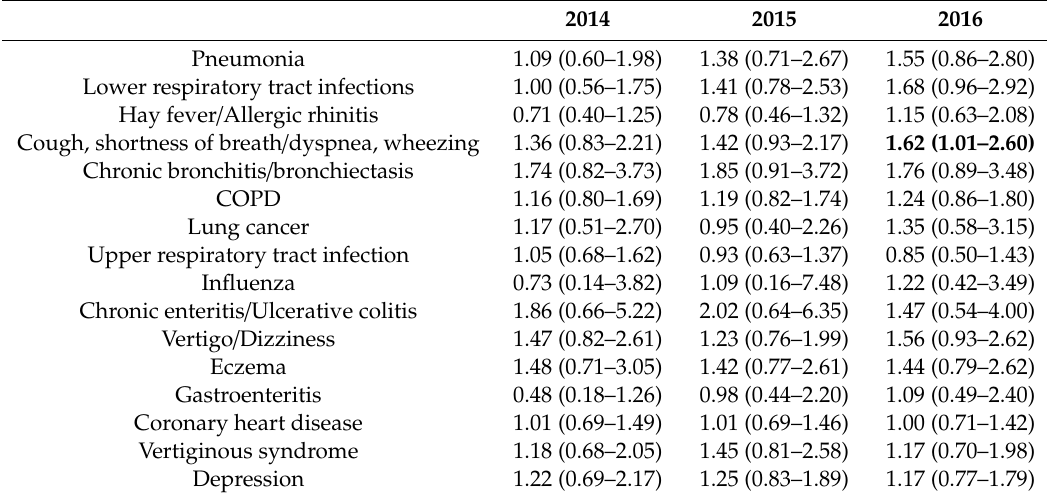
Table A14. Di ff erences (OR, 99% CI) a per year between livestock dense areas and control areas among elderly asthma patients b (statistically significant results in bold)